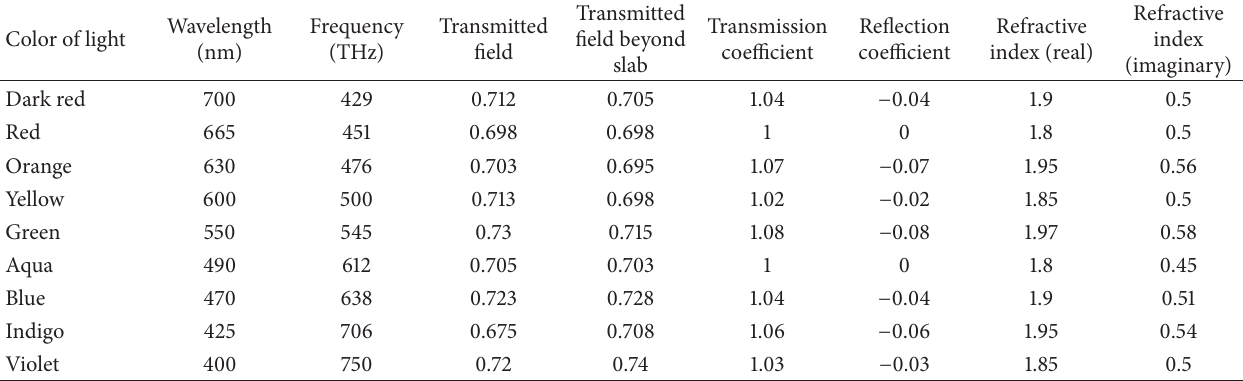
Table 2: Variations in different parameters of an optical cloaking system for a radius ratio of 2.